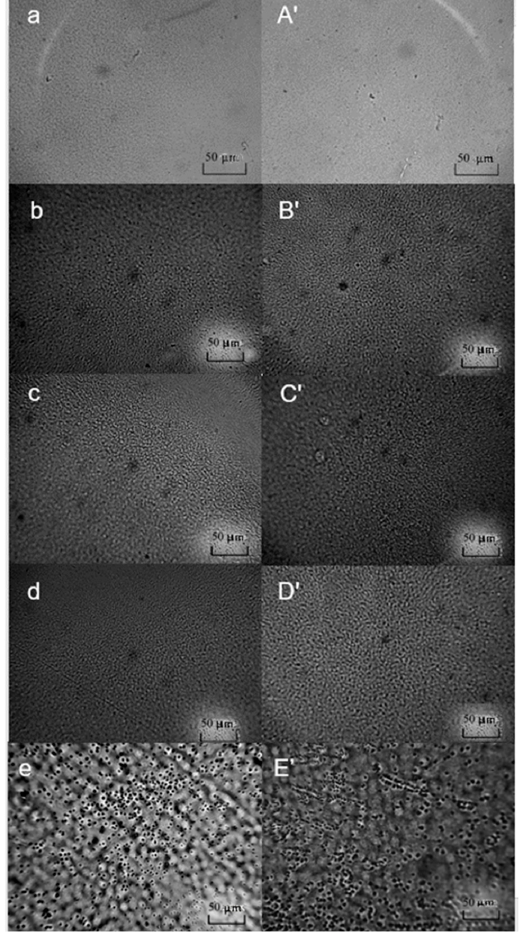
Figure 9. Optical micrographs of films from chitosan with content of NMA: 0 wt% ( a, A’ ); 5 wt% ( b, B’ ); 10 wt% ( c, C’ ); 20 wt% ( d, D’ ); 30 wt% ( e, E’ ). a, b, c, d, e—before (without) UV exposure; A’, B’, C’, D’—after UV exposure.